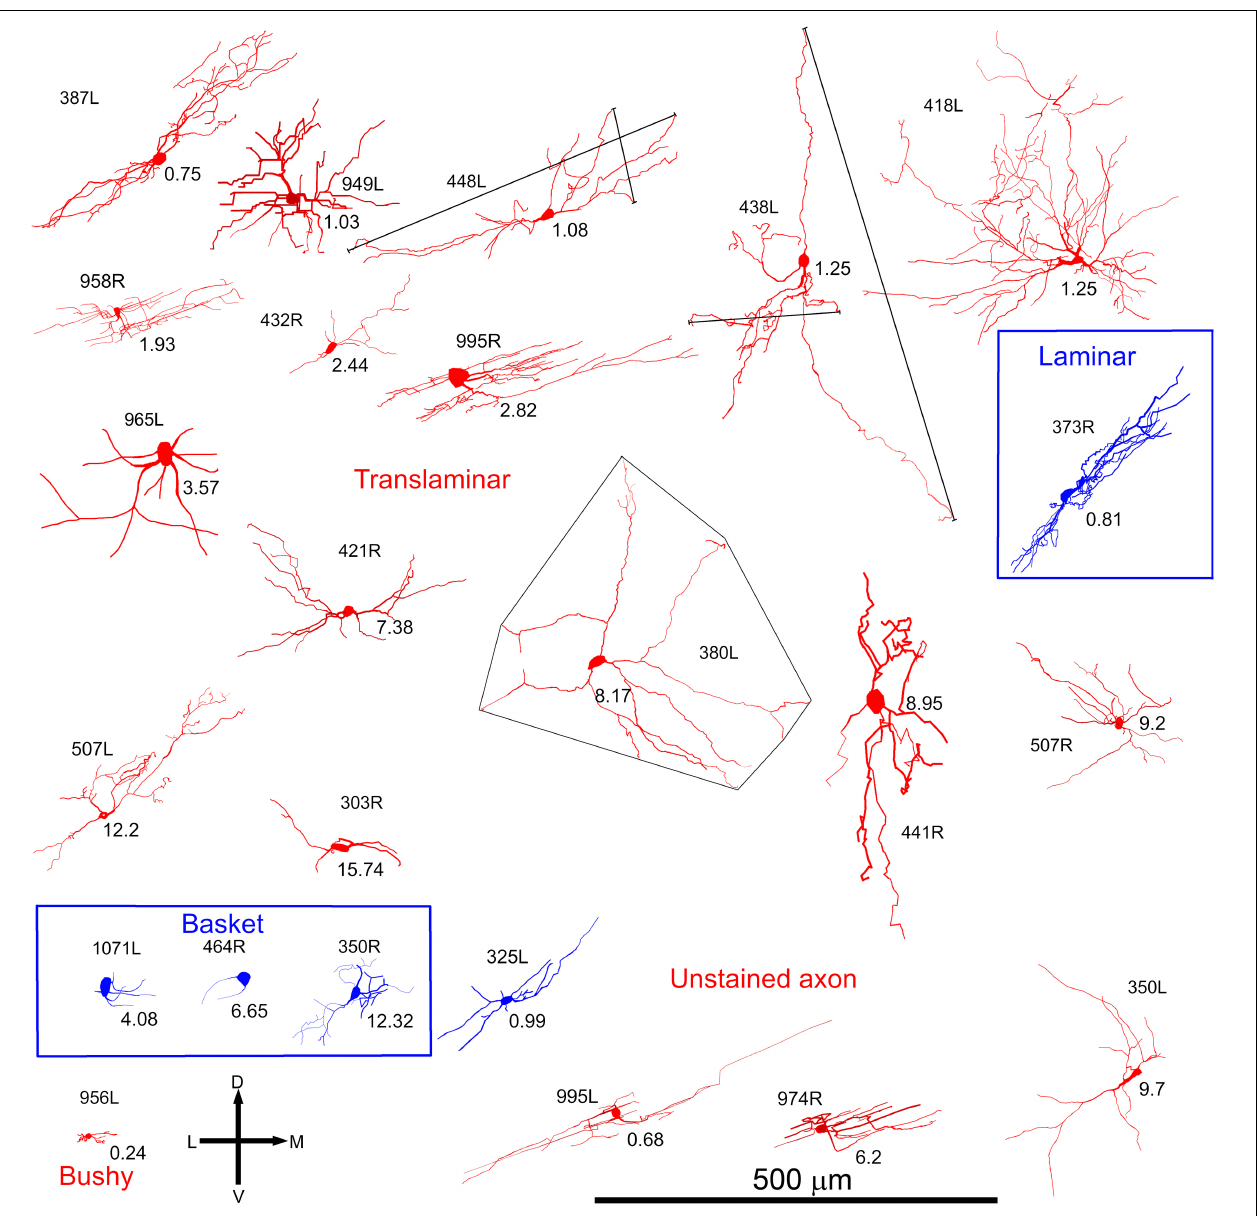
FIGURE 2 | Soma and dendrites of all 24 filled cells viewed in the coronal plane. Most cells were filled in the left IC (L suffix after # number shown to the left or above the soma) but some were filled on the right (R suffix) and these have been reversed so that all cells appear as though they were on the left. The morphology of the dendrites was measured simply by measuring the length between the tips of the two dendrites forming the long axis (see long black lines for cells 448L and 438L) and then the length between the tips of the dendrites forming the short axis (see short black lines for cells 448L and 438L). The area of the dendrites in the coronal plane was taken as that of a polygon drawn around the tips of all the dendrites (see cell 380L). The cells are organized into groups with the largest group (translaminar, 15 red cells) having a variety of dendritic morphologies but a common feature of an axon that has axonal swellings that are not confined to one fibro-dendritic lamina. They are arranged in tonotopic order, from top to bottom, with the CF (in kHz) indicated below and to the right of the soma. Related to this group are the three basket cells (blue cells) where the axon terminates in distinctive clusters of large synapses that appear to form baskets around somata located in two or more nearby fibro-dendritic laminae. The other main group of cells in the central IC is the laminar cells which have both their dendrites and their axons confined to a single fibro-dendritic lamina (one example is shown as the blue cell 373R). Of the remaining cells there were five cells with unstained axons one of which had short bushy dendrites (956L) and one of which gave a short latency chopping response to pure tones that was similar to that of the basket cells (blue cell 325L).